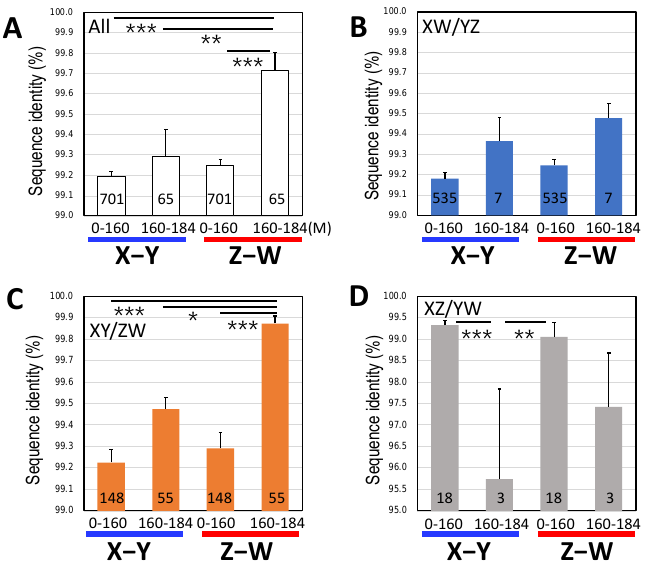
Figure 2. Composition of the sex-linked genes belonging to three different clusters along the chro- mosomal axis. The genes of the XW/YZ, XY/ZW, and XZ/YW clusters are indicated in blue, orange, and gray, respectively.